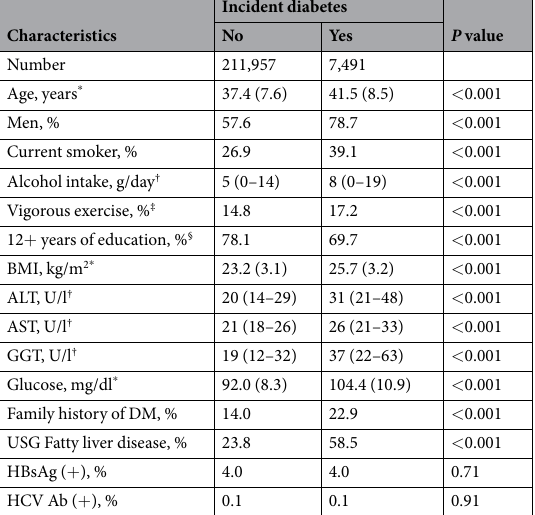
Table 3. Baseline participant characteristics by incidence of diabetes in cohort analysis ( n = 219,448). Values are * means (standard deviation), † medians (interquartile range), or percentages. ‡ ≥ 3 times per week. Abbreviations: ALT, alanine aminotransferase; AST, aspartate aminotransferase; BMI, body mass index; DM, diabetes mellitus; GGT, gamma-glutamyl transferase; USG,